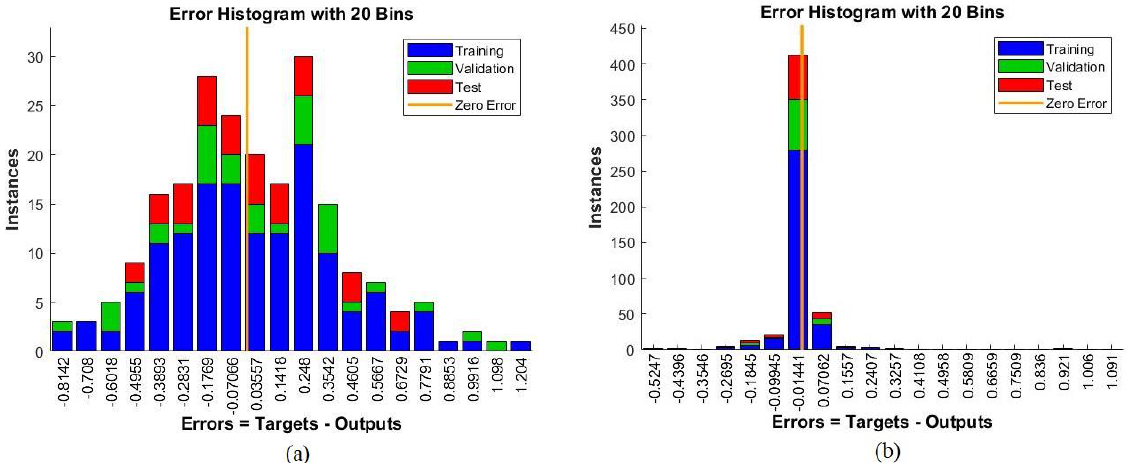
Figure 16. Error histograms of the ( a ) ALL_IDB1 and ( b ) ALL_IDB2 datasets.